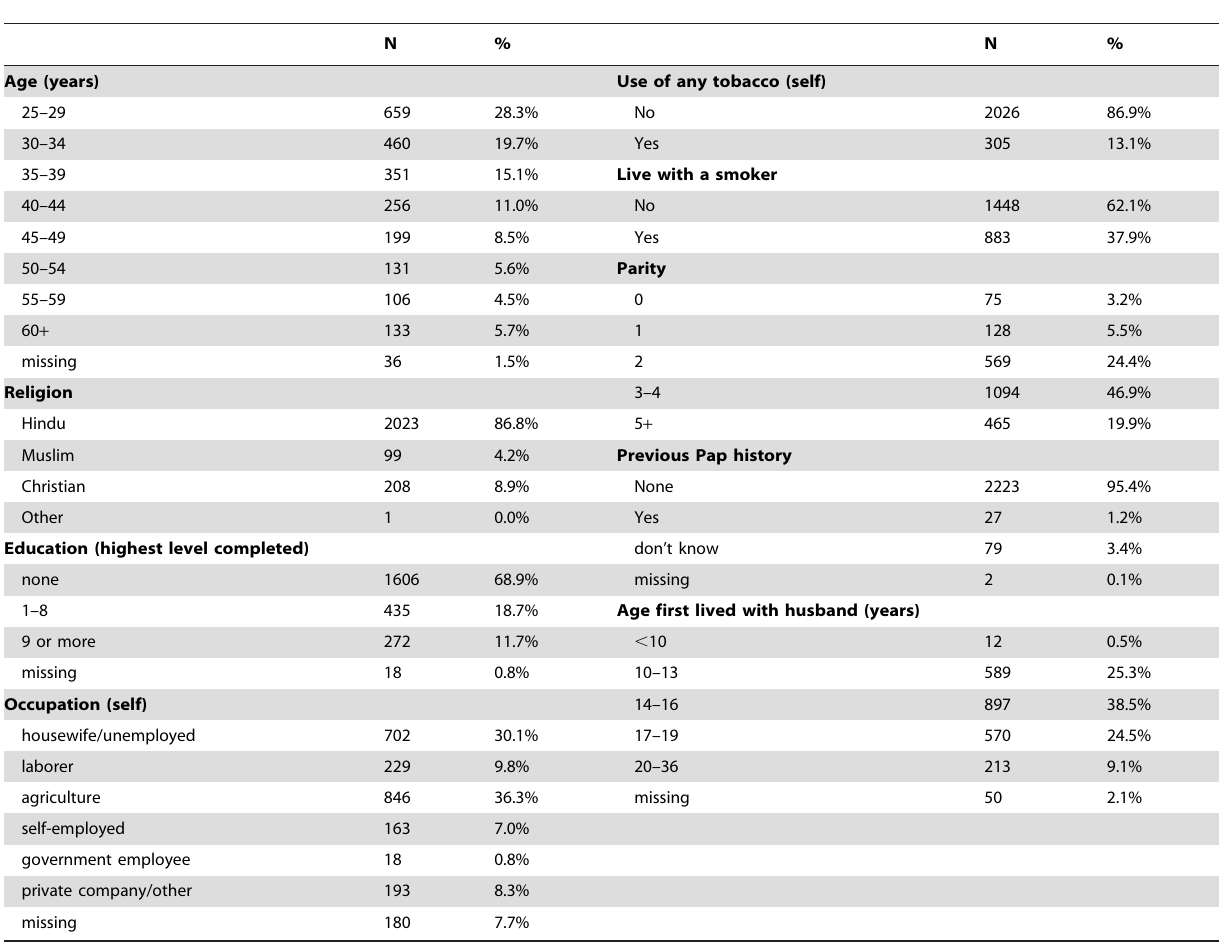
Table 1. Demographics of study population.